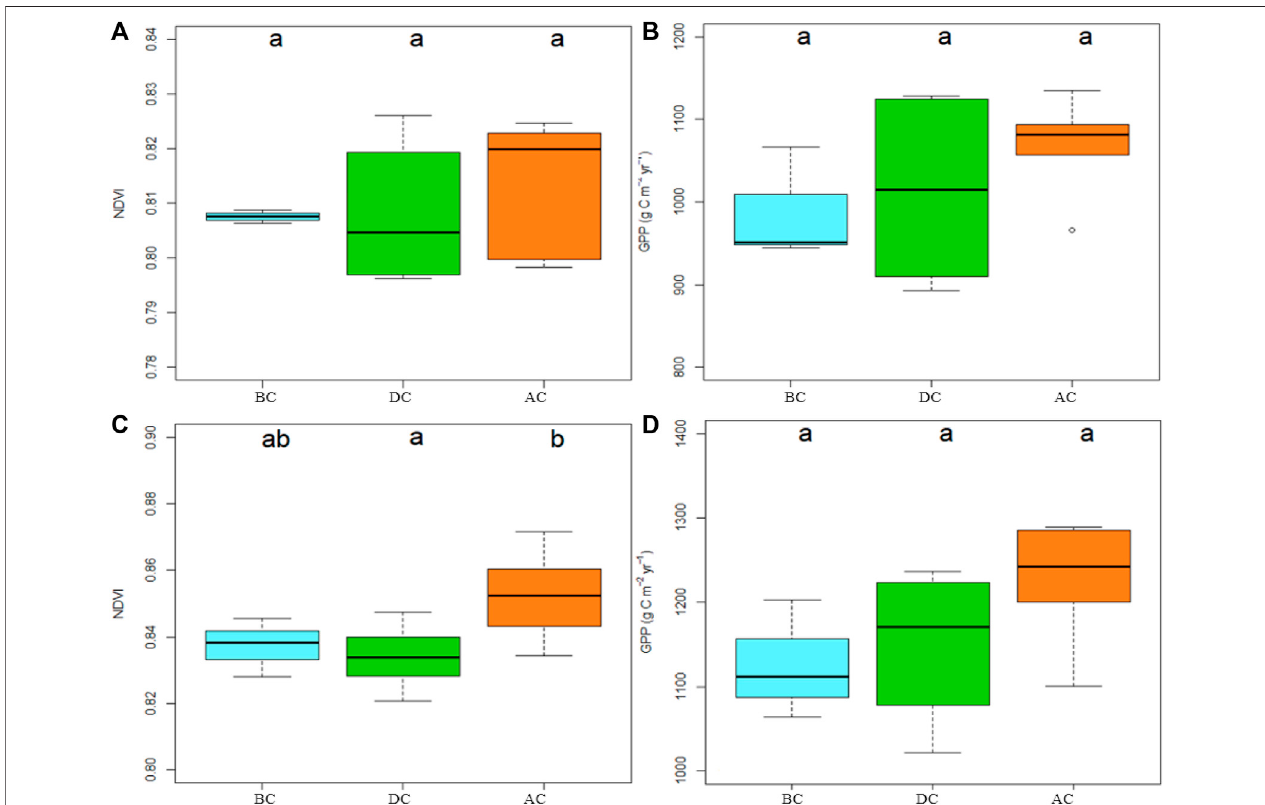
FIGURE5| BoxplotformeanannualNDVI (A,C) andGPP (B,D) before,during, and aftertunnelconstructions inthekarst (A,B) and non-karstareas (C,D) .Means followed by a common letter above the error bars are not signi fi cantly different at the signi fi cance level of 5%.